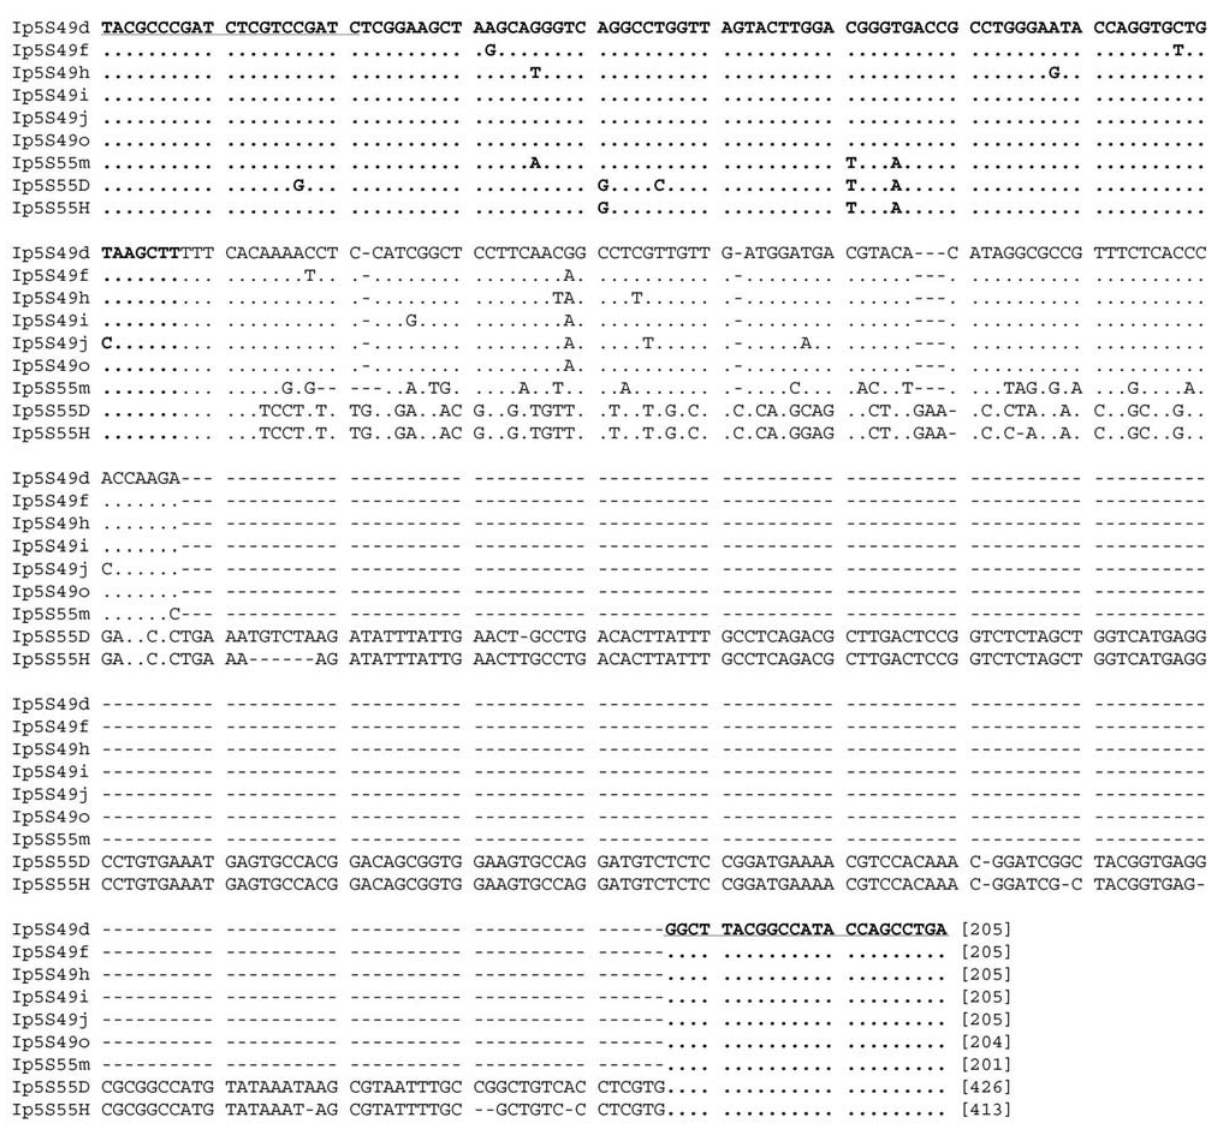
Figure 2 - Alignment of 5S rDNA nucleotide sequences of Isopisthus parvipinnis . The 5S rRNA gene coding sequence is in bold face and the primer re- gions are underlined. Dots indicate sequence identity, hyphens represent